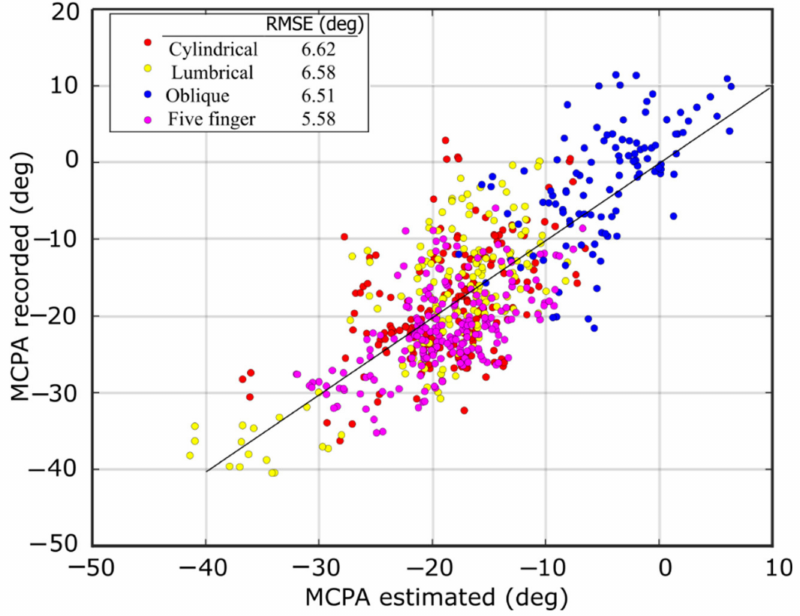
Figure 6. Root mean square error (RMSE) and recorded MCP abduction/adduction (MCPA) angles versus the estimated MCPA angles during all the postures